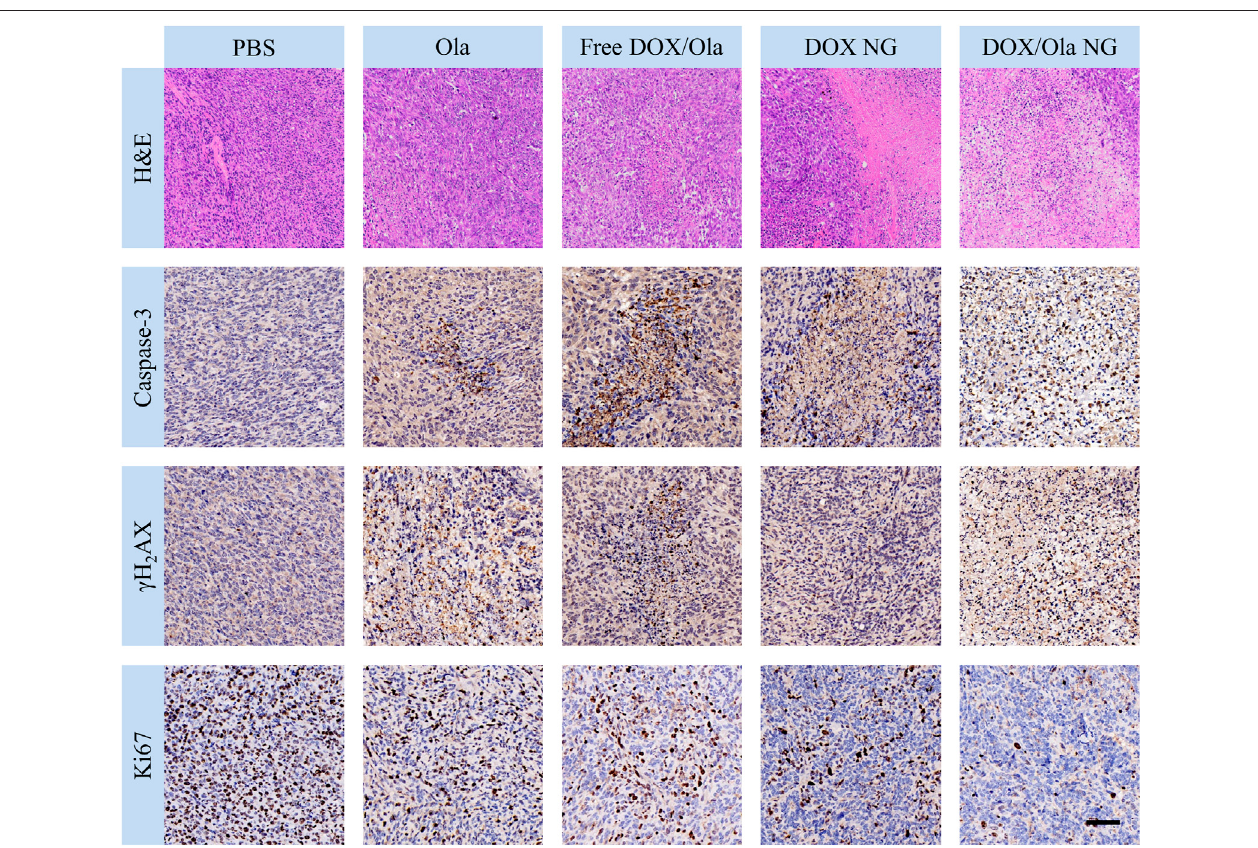
FIGURE 7 | The immunohistochemical analysis of caspase-3, γ H 2 AX, and Ki67 expression and H&E of tumor tissue. The scale bar is 100 μ m.